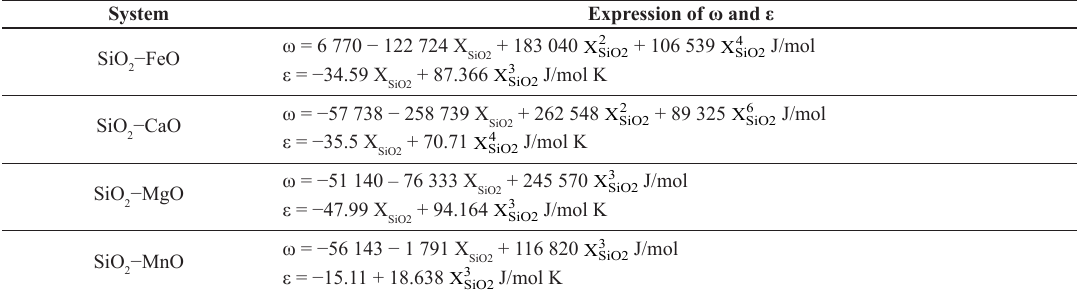
Table 1. Parameters for the thermodynamic model of binary silicate systems 8 . System Expression of ω and ε